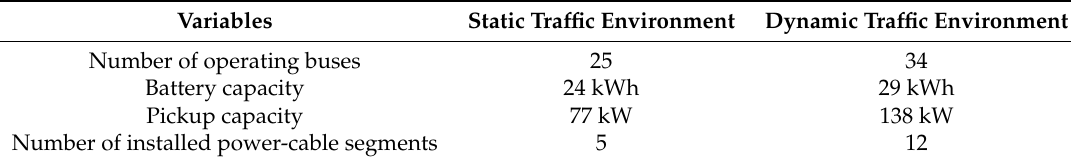
Figure 14. Cost comparison of exact and proposed algorithms in a dynamic traffic environment. Table 3. Comparison between static and dynamic traffic